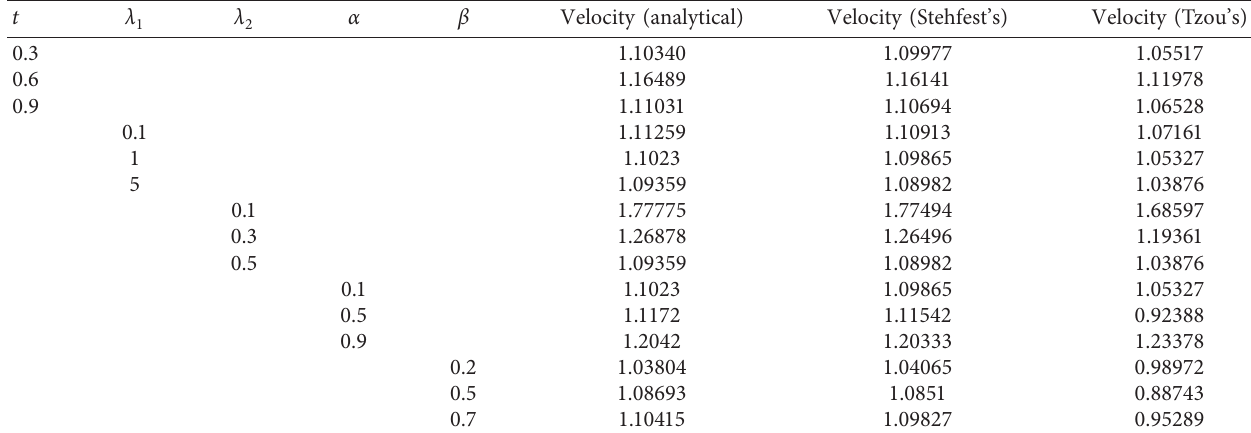
Table 3: Comparison of analytical and numerical solution for velocity profile of cos oscillation.